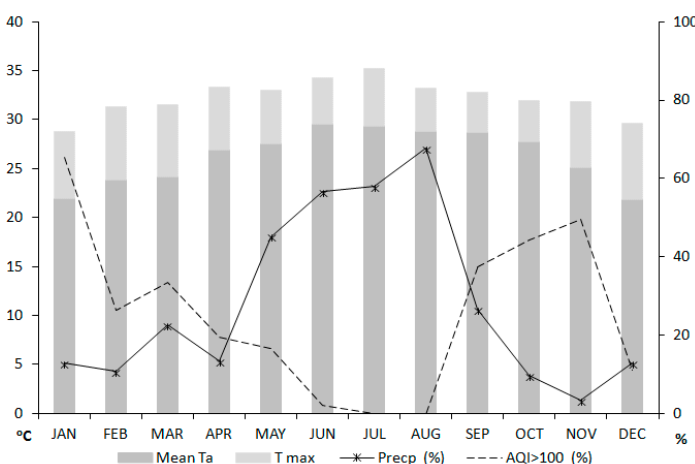
Figure 1. Kaohsiung monthly environmental conditions in 2019 (Source: monthly monitoring data from Central Weather Bureau (CWB) and Environmental Protection Administration (EPA) [13]).